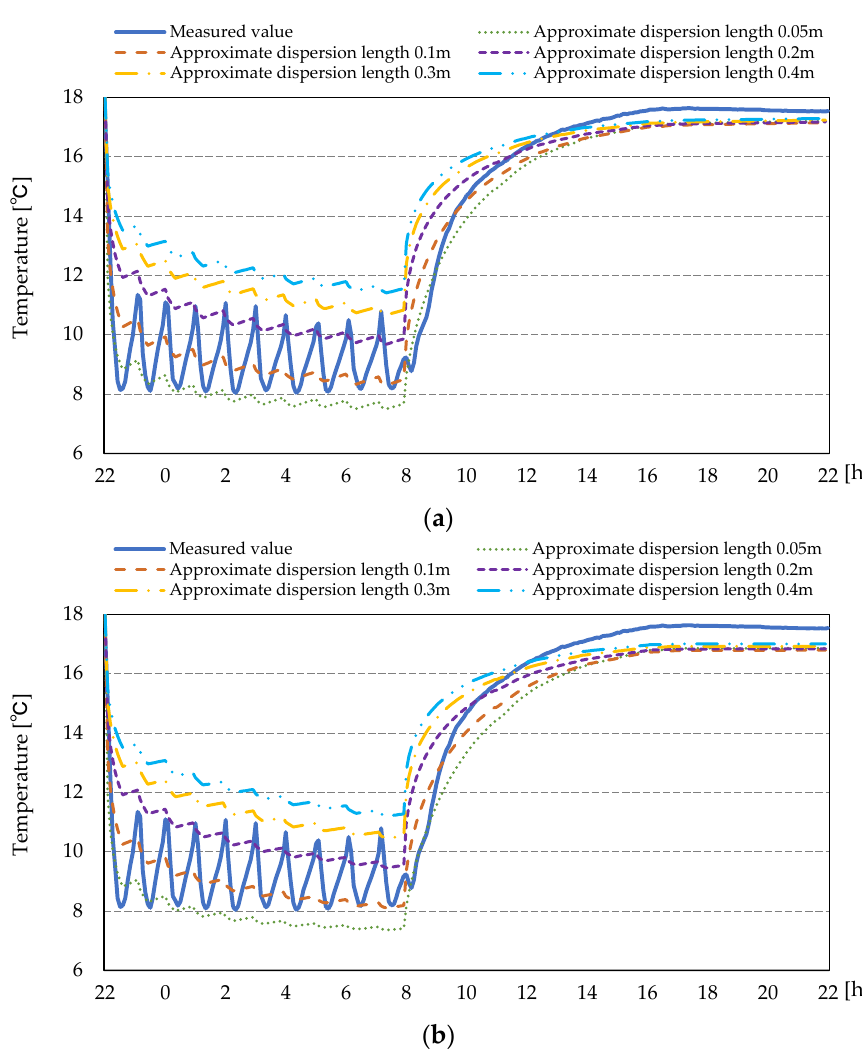
Figure 6. The calculation results of the aquifer model and the actual temperature response comparison in the aquifer: dispersion length of ( a ) dispersion length 0.002 m; ( b ) dispersion length 4 m.